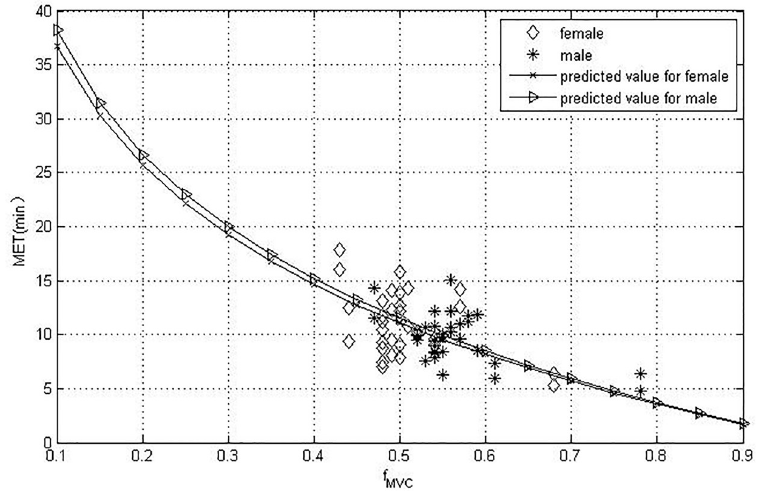
Fig 3. Predicted MET and scatter plot of MET versus f MVC .